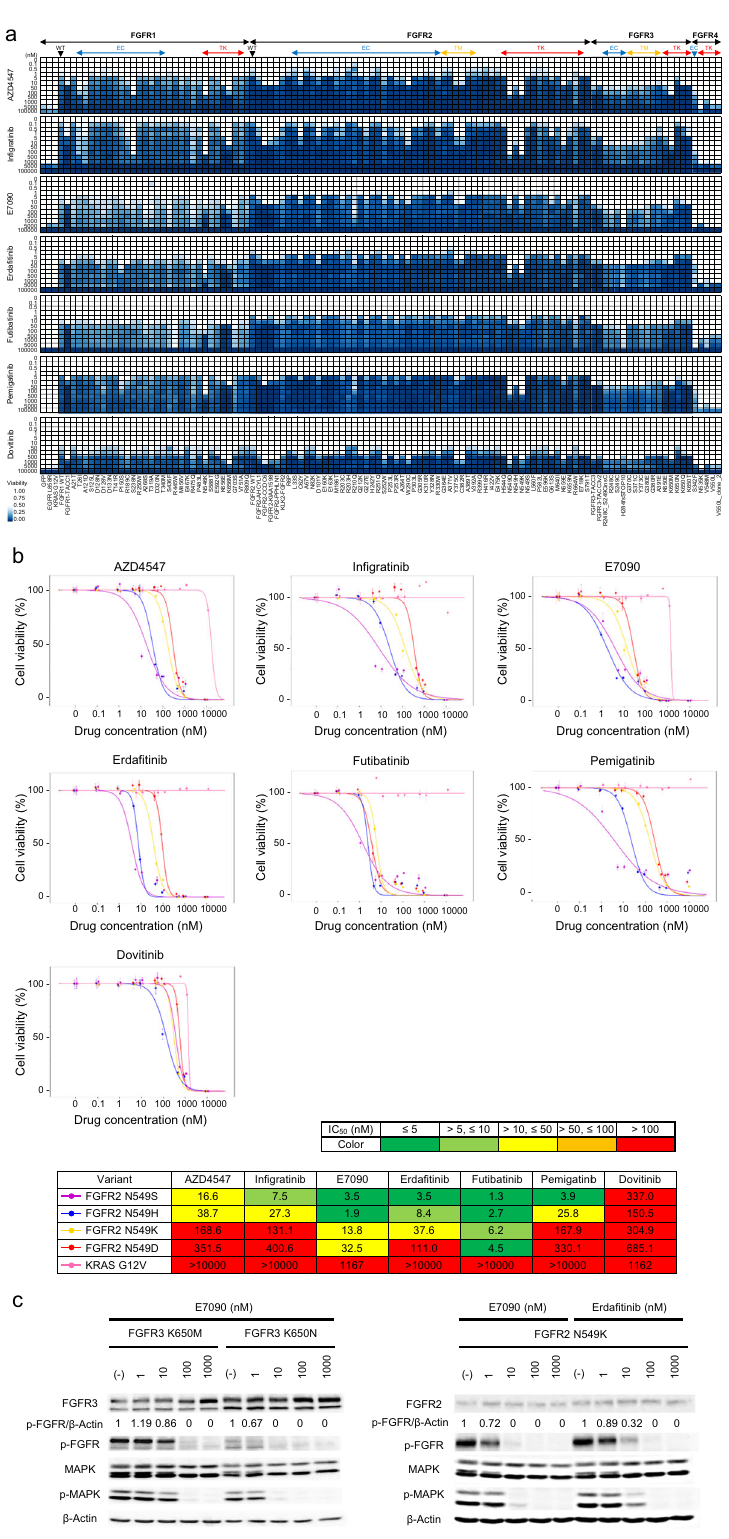
after a longer time (up to 2 weeks, depending on the speed of tumor growth). Therefore, in vitro IC 50 needs to be evaluated in combination with the oncogenicity of variant to apply the data into clinical